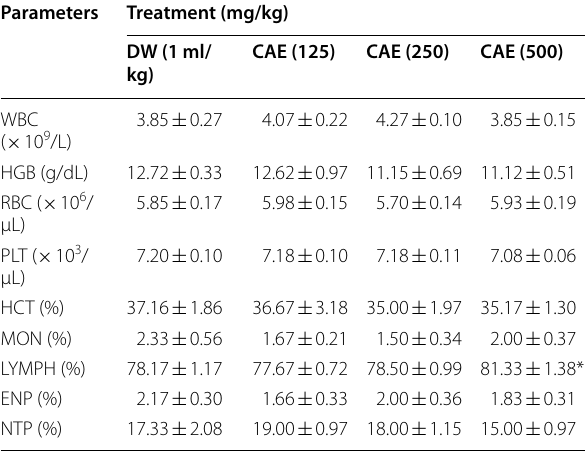
The values were tabulated as mean group (one-way ANOVA followed by Dunnett’s post hoc test), n